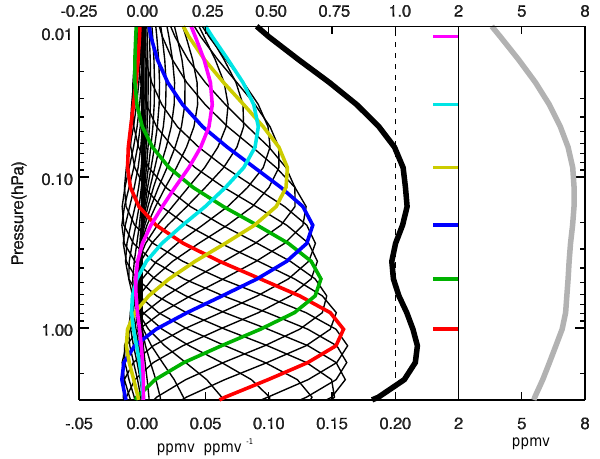
Figure 2. Left: a typical set of averaging kernels for GBMW re- trievals (in this case for retrievals from Mauna Loa). The thin lines are referenced to the lower x axis and represent the sensitivity of the measurement to perturbations at individual pressure levels. Cer- tain levels are indicated by colored lines. For these lines the level of the perturbation is indicated by the short colored lines on the right. Generally this colored line is near the peak of the respective kernel, but at the higher altitudes where the sensitivity begins to drop <1 an offset develops. The single thick black line is referenced to the upper x axis and indicates the sum of the averaging kernels at that level. Ideally the sum of these kernels is near unity, as indicated by the dashed line. Right: the gray line shows the water vapor profile obtained for this particular retrieval from Mauna